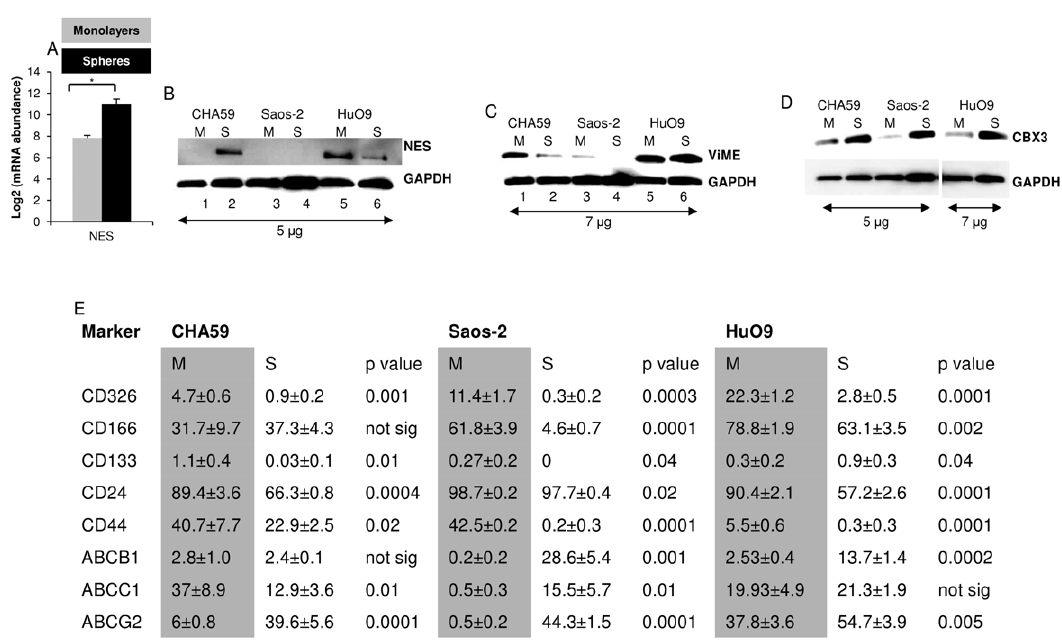
Figure 4. Differential transcript and protein expression in monolayers and spheres. (A) Nestin (NES) transcript in CHA59 monolayers and spheres measured by microarray analysis, * p , 0.05. (B) Nestin (NES), (C) vimetin (VIME), and (D) chromobox protein homolog 3 (CBX3) protein expression in CHA59, Saos-2, and HuO9 cells tested by western blotting. ‘M’ represents monolayers, ‘S’ represents spheres. (E) Immunophenotype of monolayers and spheres probed by flow cytometry. CHA59 and Saos-2 immunophenotype reported as a cumulative of 6-color panel (CD326, CD166, CD133, CD24, CD44, excludes ABCB1) and 3-color panel (ABCB1, ABCC1, ABCG2). HuO9 immunophenotype reported as a cumulative of 6-color panel (CD326, CD166, CD133, CD24, CD44, ABCB1) and 2-color panel (ABCC1, ABCG2). p value calculated for monolayers vs. spheres for each cell line. ‘M’ represents monolayers, ‘S’ represents spheres.